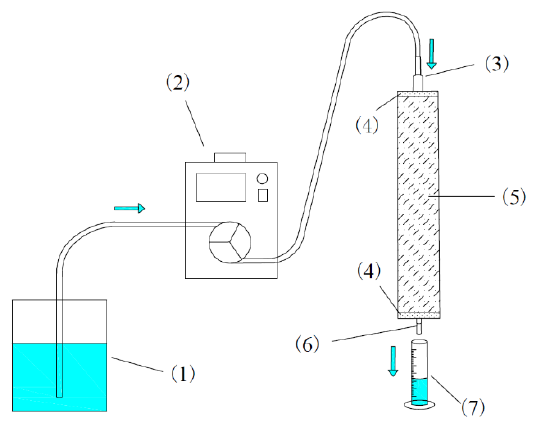
Figure 1. Experimental set-up of the soil column: (1) reservoir, (2) peristaltic pump, (3) inlet, (4) quartz sand, (5) soil, (6) outlet, (7) waste. Experiment design: A total of 2.55 kg soil was weighed from the soil samples, and 1.4